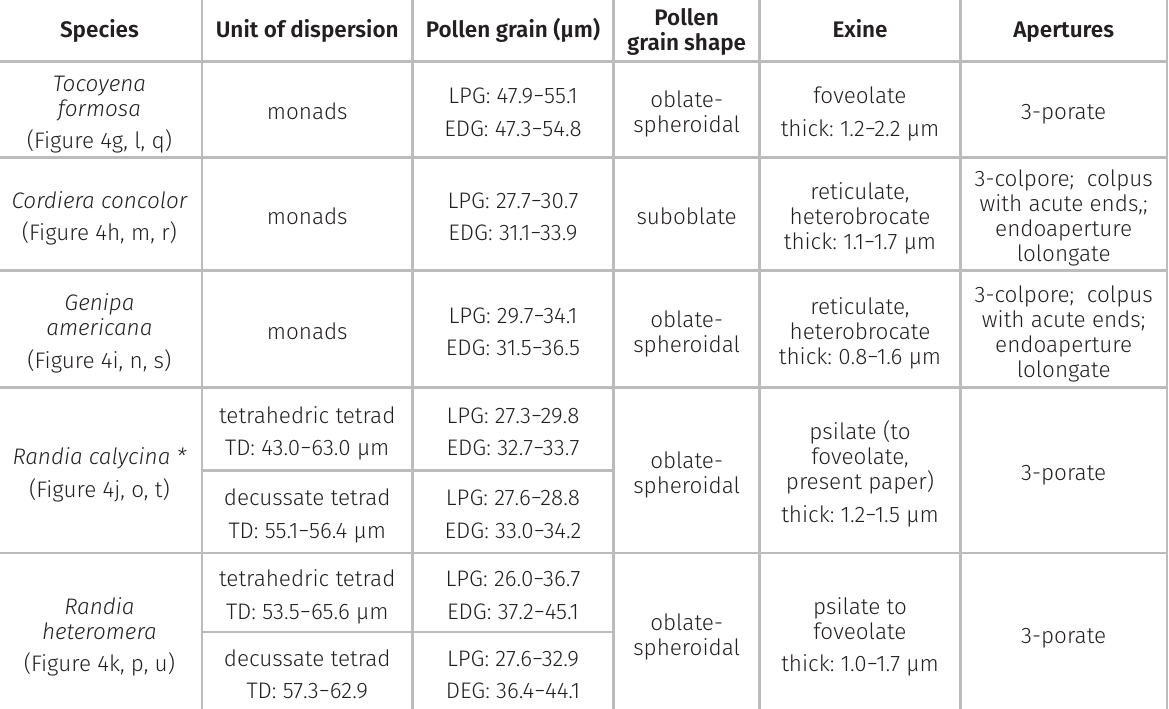
Table II. Morphology and dispersal units of the pollen in the species analysed of Gardenieae. Abbreviations: EDG= equatorial diameter of pollen grain, LPG= length of the polar axis of the pollen grain, TD: tetrad diameter. *: data from Judkevich et al .